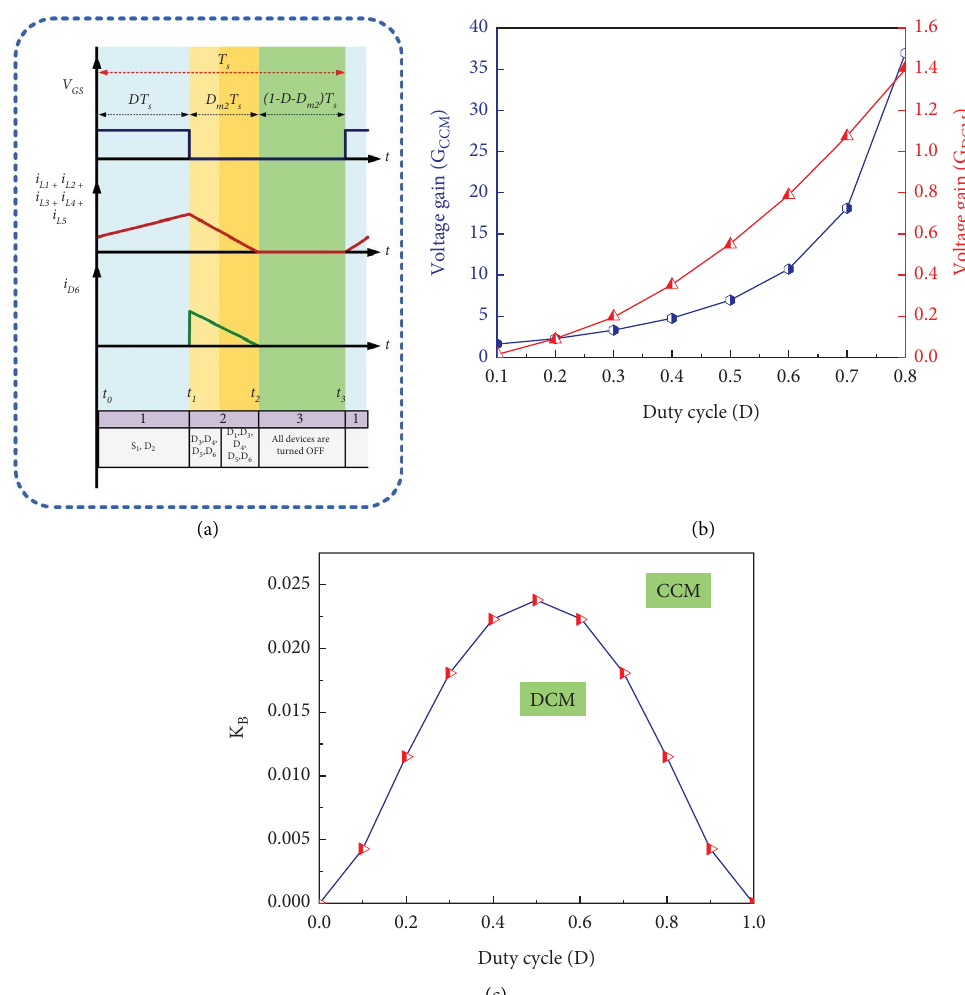
Figure 7: (a) Analytical waveform under DCM operation. (b) Voltage gain of CCM and DCM versus duty cycle. (c) ( K